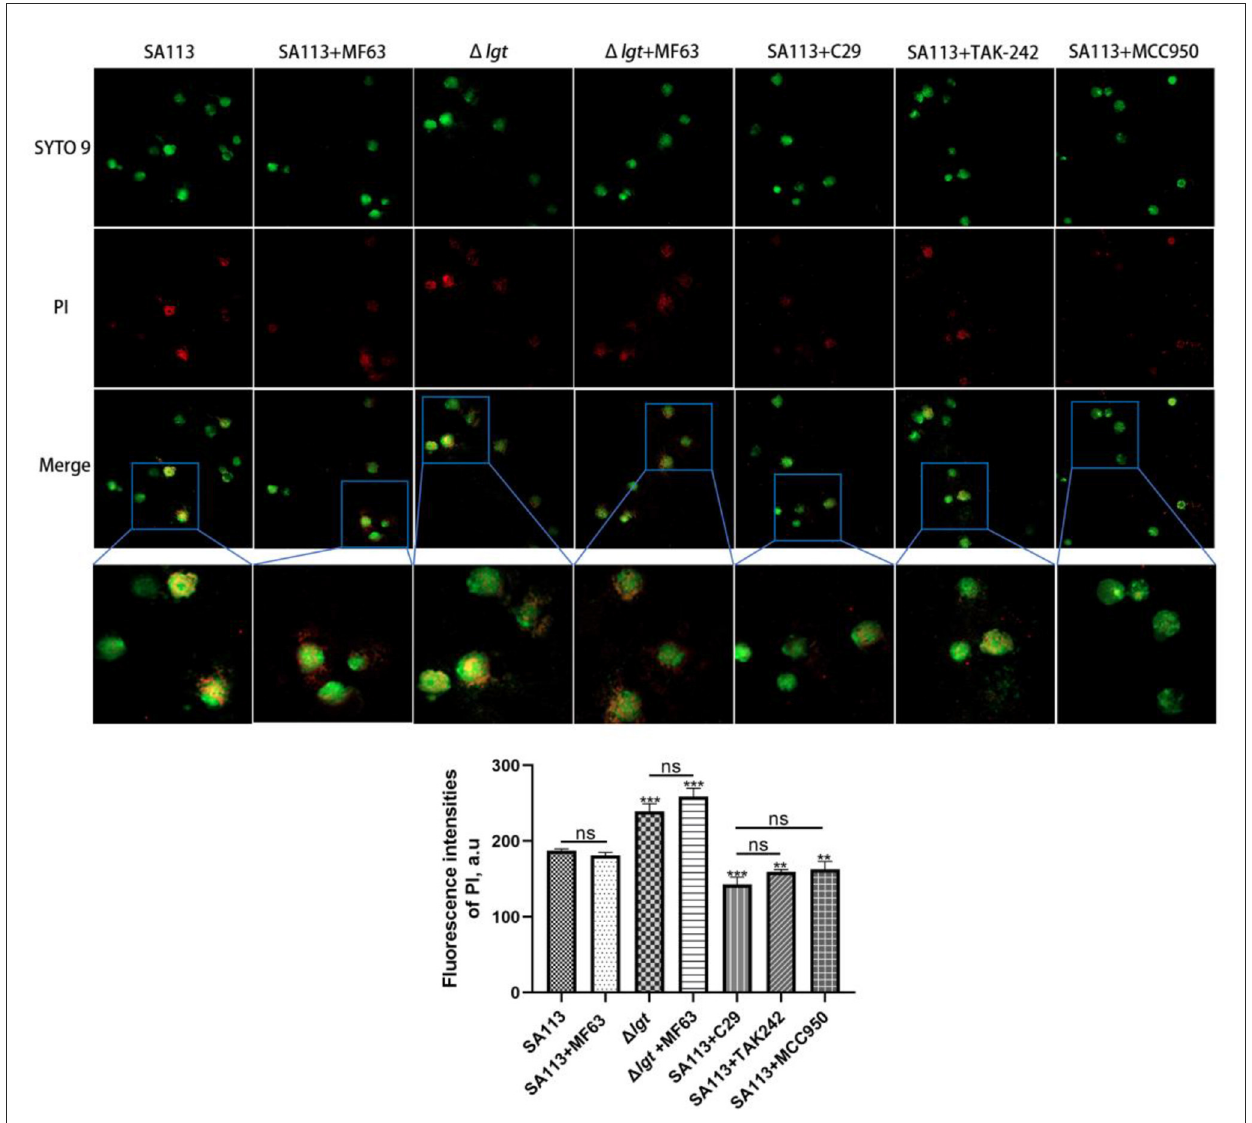
FIGURE5 TLR2, TLR4, and NLRP3 receptors are involved in the intracellular killing of S. aureus by neutrophils, and S. aureus lacking lipoprotein is more likely to be killed, but PGE 2 does not affect the killing of cells. Bacterial intracellular killing of PI (red)-labeled dead S. aureus within SYTO9-labeled neutrophils (green) was analyzed by microscopy assay (400 × ). ns P > 0.05, * P < 0.05; ** P < 0.01; *** P <